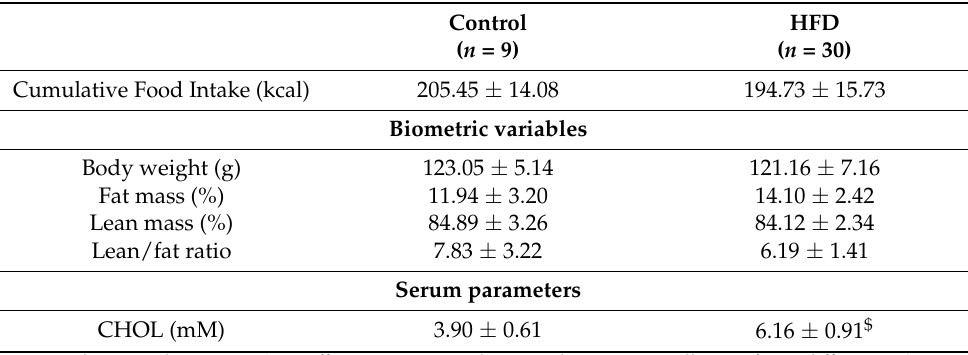
Table 1. Energy intake, body composition and serum parameters of hamsters fed with a NFD (control group) or HFD (HFD group) at the 8th week of the